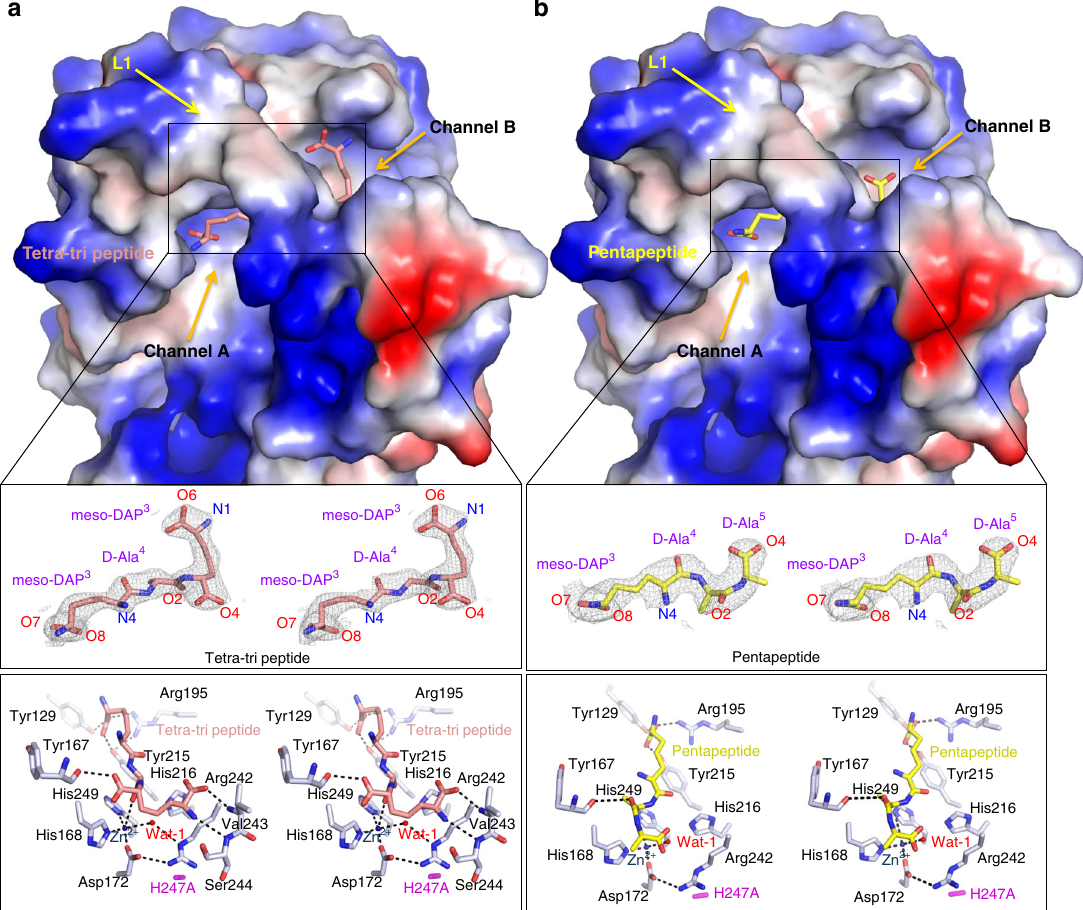
Fig. 3 Structures of Pgp3 H247A mutant in complex with tetra-tri and pentapeptide. a Surface representation of the electrostatic potential of Pgp3 in complex with tetra-tri peptide. The bound m DAP 3 - D -Ala 4 - m DAP 3 moiety is shown in pink sticks for carbons and expanded with the stereo 2F O – F C electron density map (1.0 σ ). Tetrahedral coordination of Zn 2 + and hydrogen bonds are represented by black dotted lines, whereas red spheres represent water molecules. b Surface representation of the electrostatic potential of Pgp3 in complex with pentapeptide. The bound m DAP 3 - D -Ala 4 - D -Ala 5 moiety is shown in yellow sticks for carbons and expanded with the stereo 2F O – F C electron density map (1.0 σ